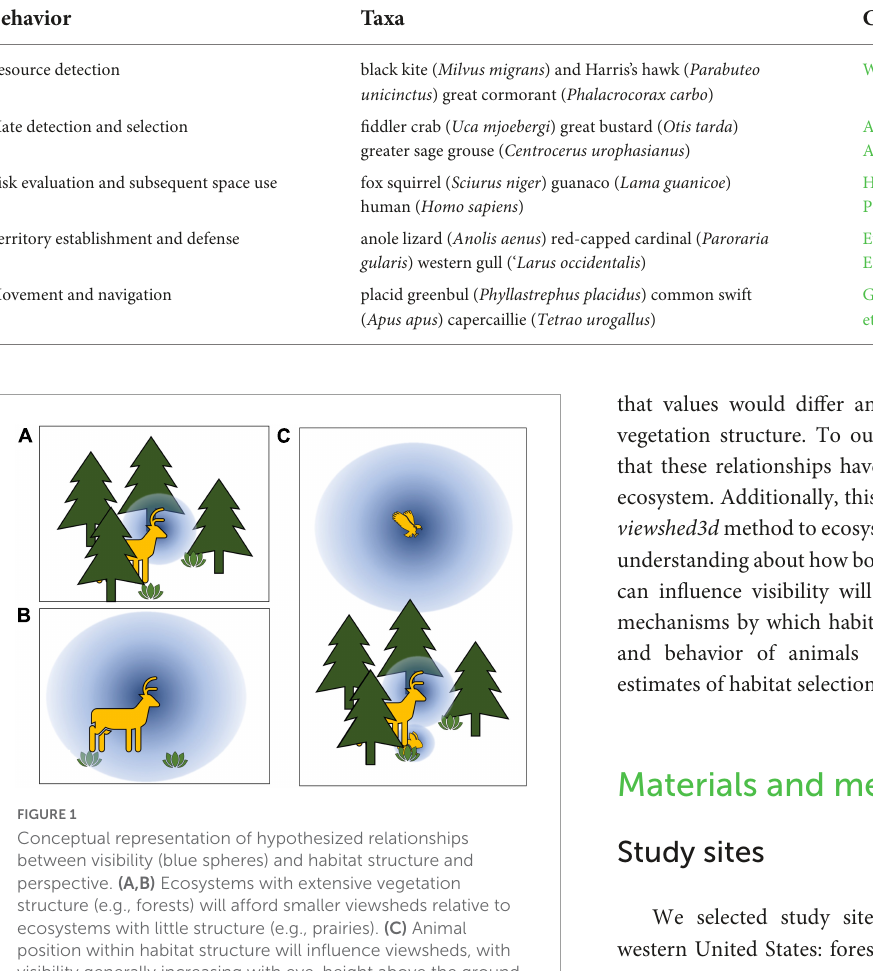
TABLE 1 Examples of behaviors that are influenced by visibility in animals and humans.